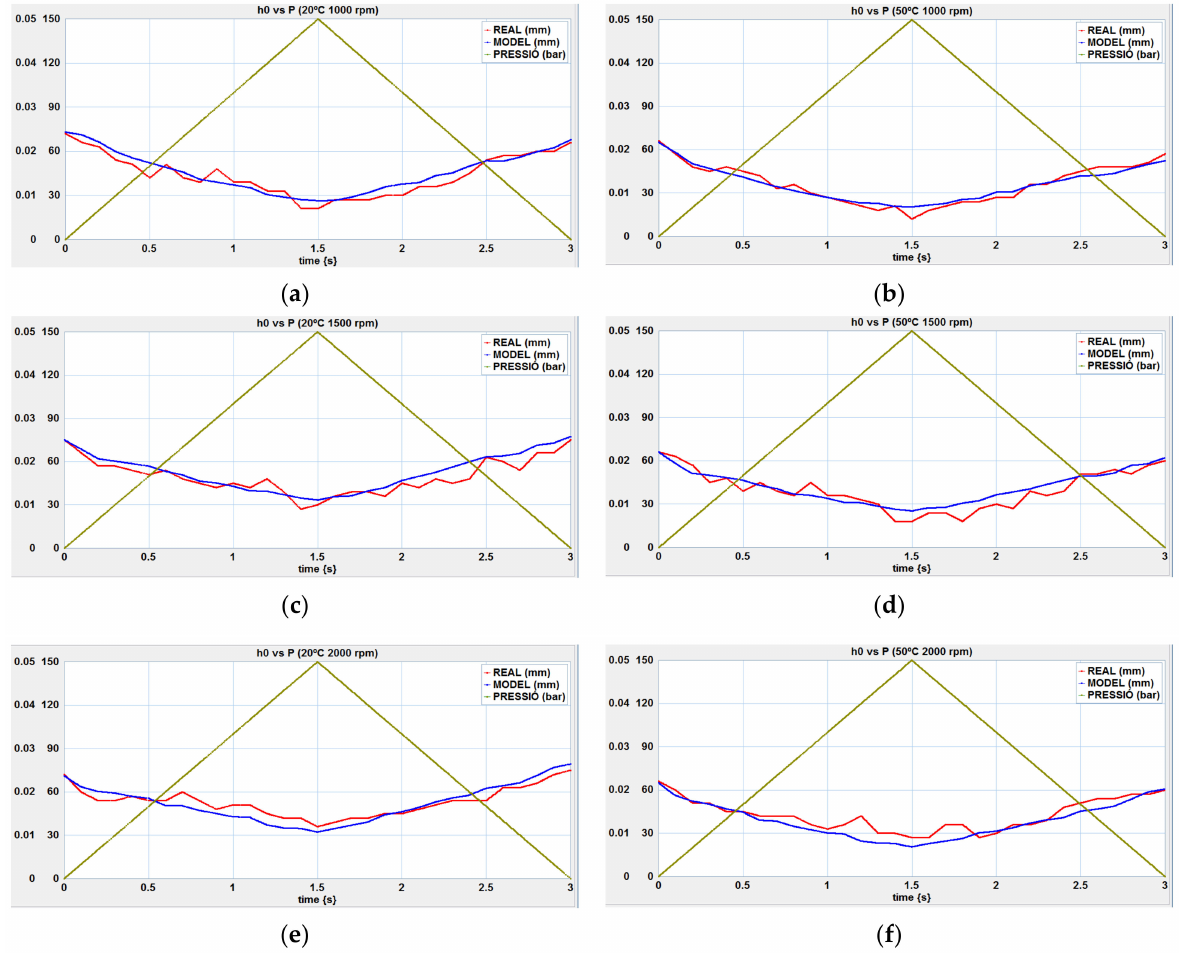
Figure 10. Minimum film thickness: ( a ) 20 ◦ C, 1000 rpm; ( b ) 50 ◦ C, 1000 rpm; ( c ) 20 ◦ C, 1500 rpm; ( d ) 50 ◦ C, 1500 rpm; ( e ) 20 ◦ C, 2000 rpm; and ( f ) 50 ◦ C, 2000 rpm (red line—experimental test, blue